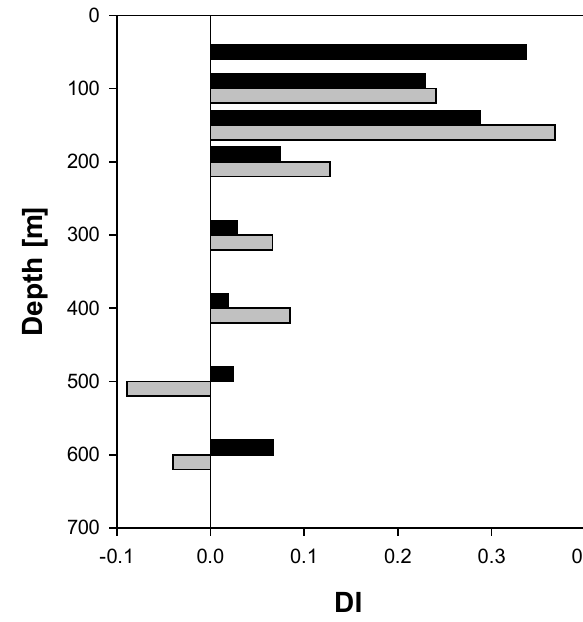
Figure 7. Degradation index (DI) of organic matter in trap-collected sinking particles based on amino acid composition and calculated according to Dauwe et al. (1999). Black bars are used for deploy- ment no. 1 and gray bars for deployment no.